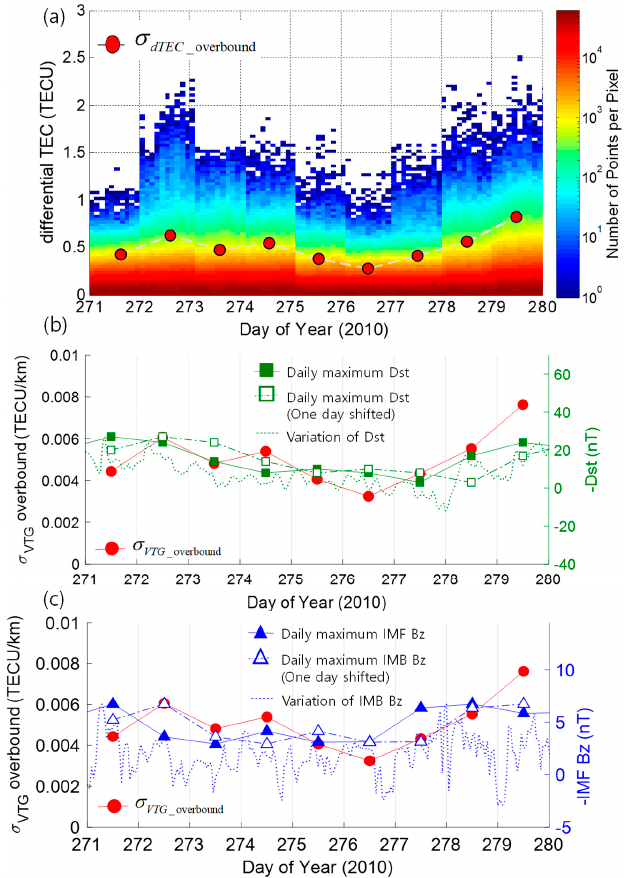
Figure 5. A series of differential TECs of differential TEC in 2010 ( a ), a comparison between σ VTG_overbound and corresponding daily and hourly maxima of negative Dst ( b ), and negative interplanetary magnetic field (IMF) Bz ( c ), respectively. One day shifted negative Dst, and IMF Bz plots are also compared to the σ VTG_overbound .